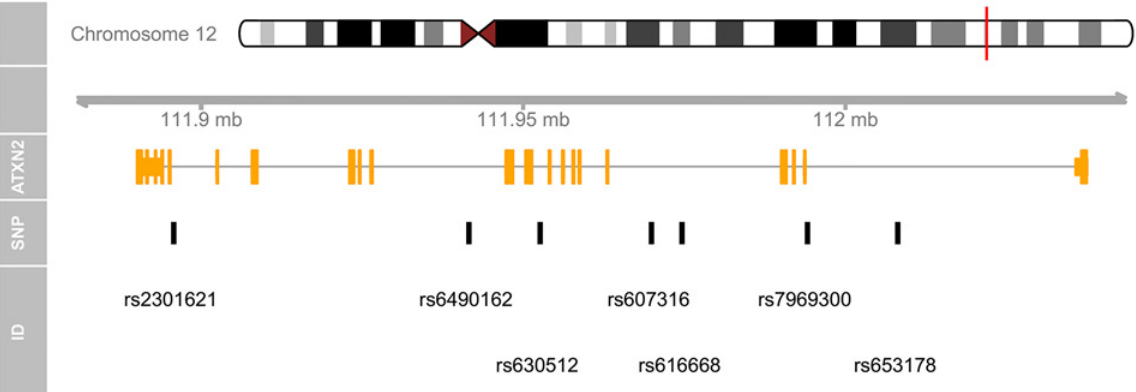
Fig 2. A concise genomic map for seven SNPs within ATXN2 using UCSC database. At the top, the relevant chromosome is drawn with the subregion of interest marked in red. The ‘ ATXN2 ’ track shows the combined gene model of the alternative transcripts of the ATXN2 gene. At the bottom, the SNPs ’ location and ID are plotted along the same genomic coordinate. > library(TxDb.Hsapiens.UCSC.hg19.knownGene) > msb(M = snp, start = 111950277, end = 112036294, geneTrName = ‘ ATXN2 ’